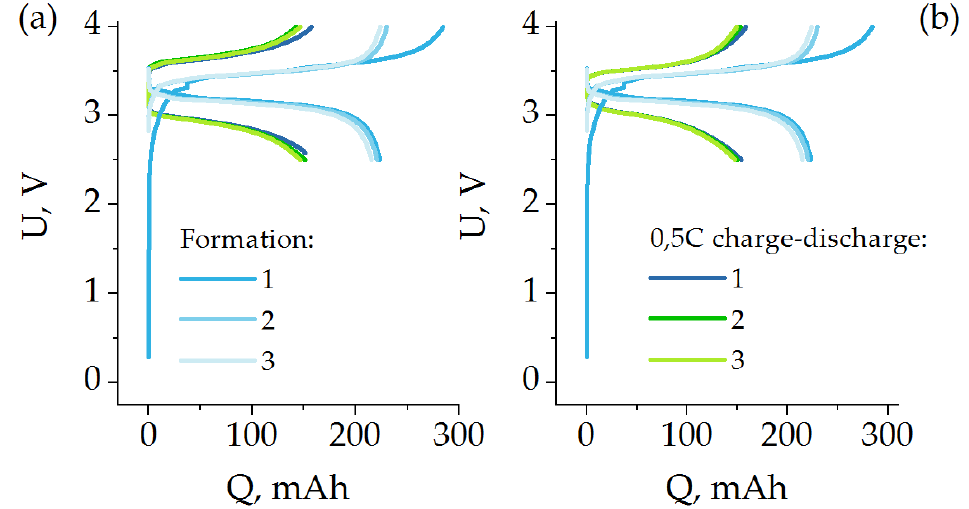
Figure 7. Formation at 0.1 C and 0.5 C charge-discharge cycles for Al/LFP pouch cell ( a ) and Al/poly/LFP pouch cell ( b ). Al/poly/LFP pouch cell ( b